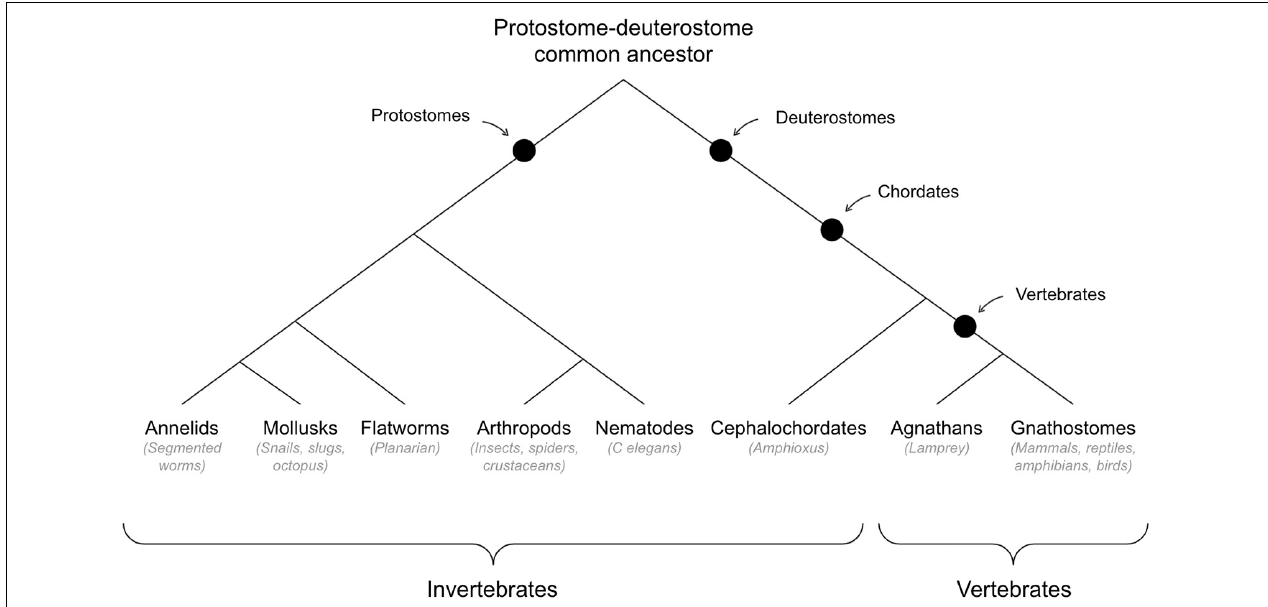
FIGURE 3 | Cladogram of vertebrate-invertebrate